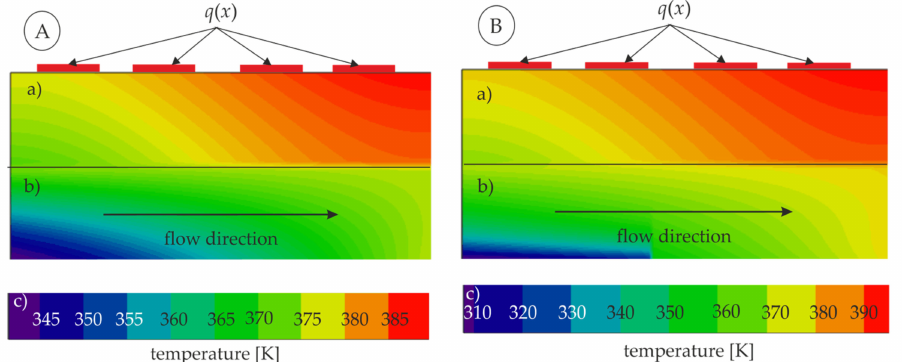
Figure 12. Two-dimensional temperature fields of ( a ) the copper block and ( b ) flowing fluid obtained by the Tre ff tz method for ( A ) heat flux q = 223.2 kW / m 2 and mass flux G = 5.9 kg / (m 2 s) and ( B ) heat flux q = 340 kW / m 2 ,mass flux G = 5.9 kg / (m 2 s), (pictorial view, not to